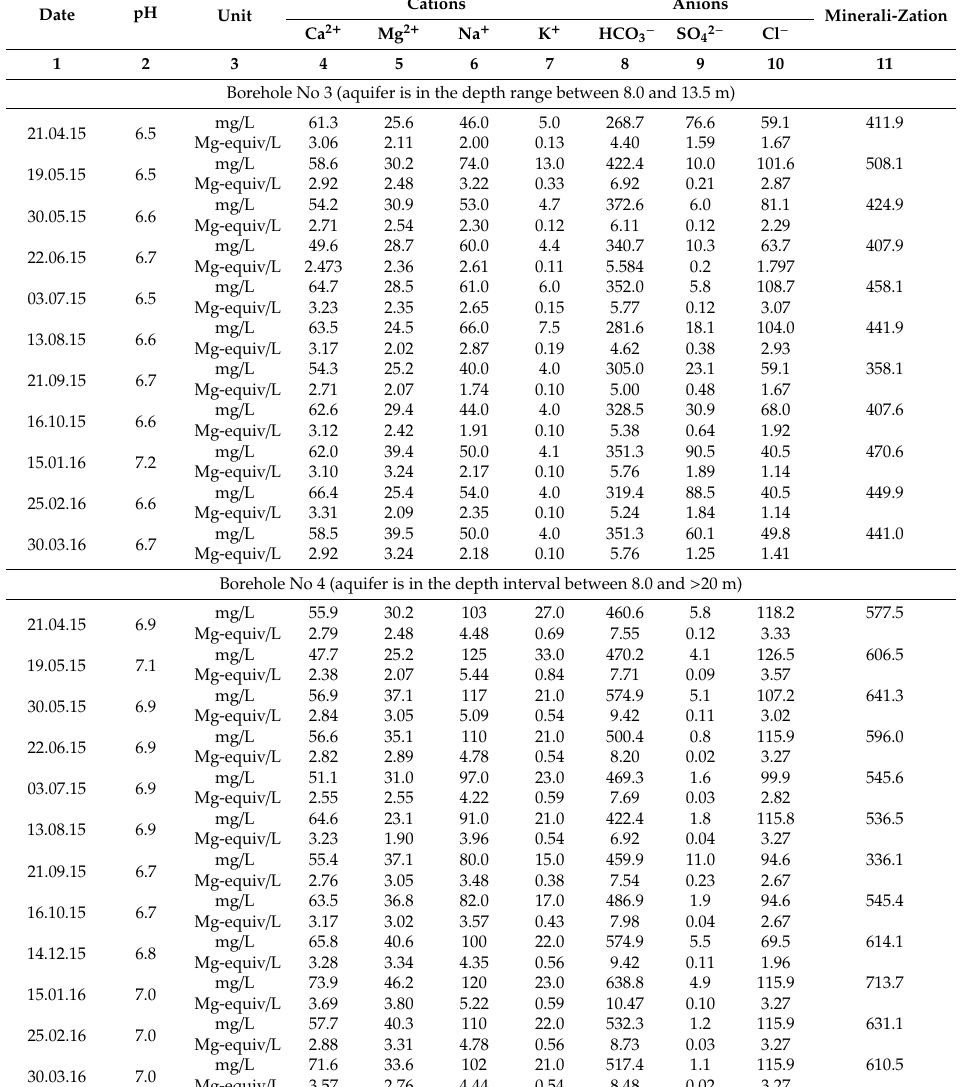
Figure 7. Chemical composition of natural waters in the study area (Piper diagram): 1–3 groundwater in suprapermafrost taliks: 1—taliks induced by fill placement; 2—taliks in Quaternary deposits beneath the Lena River; 3—taliks in Jurassic rocks beneath the Lena River; 4—Lena River water in winter; 5—precipitation. Table 2. Chemistry of surface and subsurface waters in the study area in